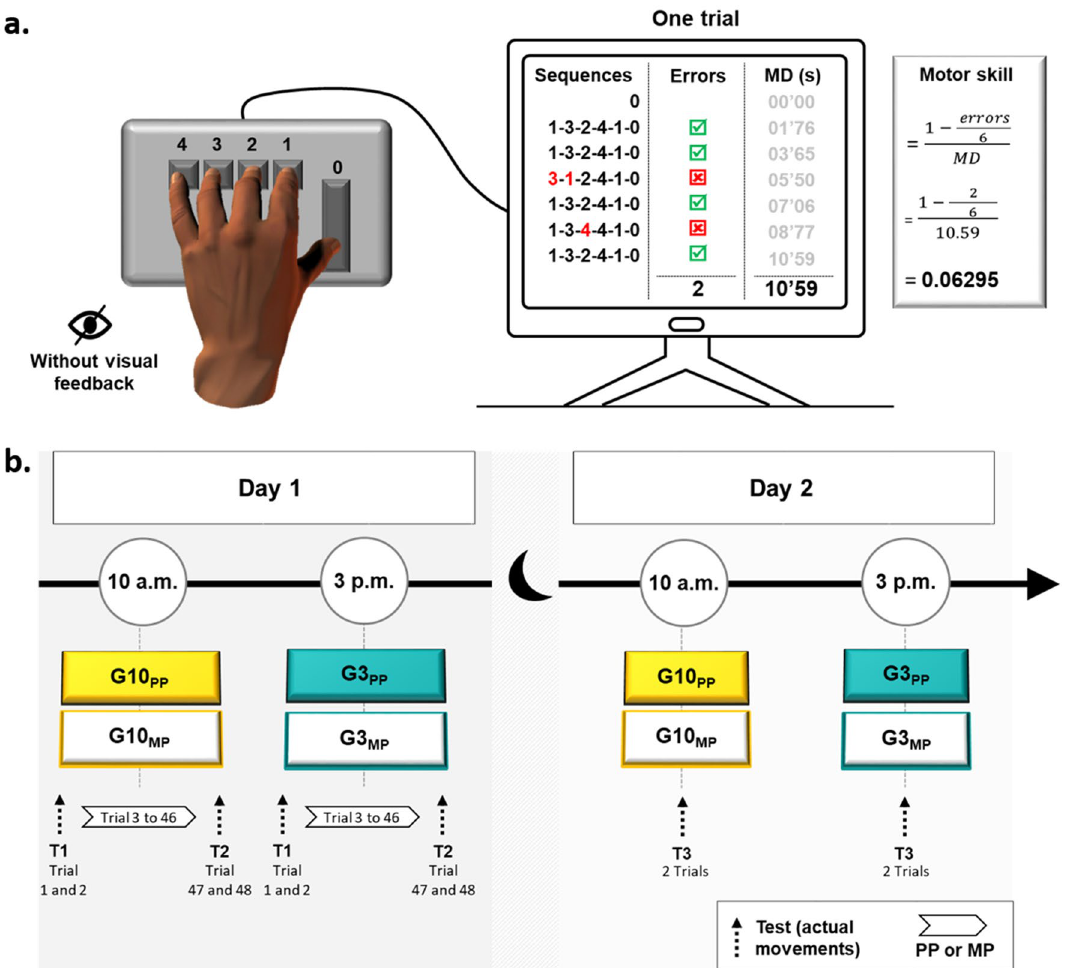
Figure 1. Illustration of experimental device and procedure. ( a ) The computerized version of the sequential finger-tapping task. Each key was affected to a specific finger of participants’ left hand: 0 (thumb), 1 (index), 2 (middle), 3 (ring), and 4 (little). Participants were requested to tap the following sequence as accurately and as fast as possible: 1-3-2-4-1-0. Six consecutive sequences composed one trial. Accuracy was defined as the number of false sequences (Errors) throughout one trial. Movement duration (MD) was defined as the time interval between the start of the trial (the first pressure on the key ‘0’) and the end of the trial (the last pressure on the key ‘0’, at the end of the 6th sequence). Motor skill is a composite ratio of duration and accuracy. ( b ) Experimental procedure. The participants were divided into four groups: G10 PP physically trained at 10 a.m., G10 MP mentally trained at 10 a.m., G3 PP physically trained at 3 p.m., and G3 MP mentally trained at 3 p.m. The protocol was scheduled on two consecutive days. The Day 1, participants were trained on 48 trials: the two first trials and the last two trials were physically performed and composed T1 and T2, respectively. The remaining 44 trials constituted physical or mental practice. The Day 2, participants physically performed two trials 24 h later